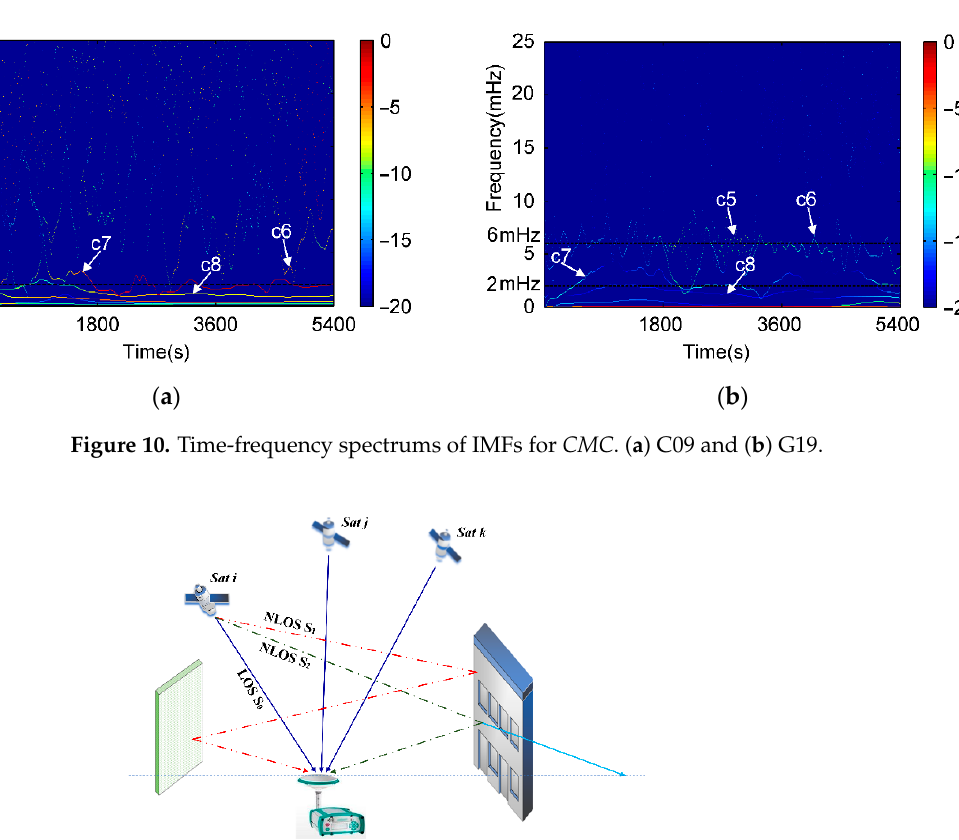
Figure 9. PSD for each decomposed layer from CMC using HHT. ( a ) C09 and ( b ) G19.